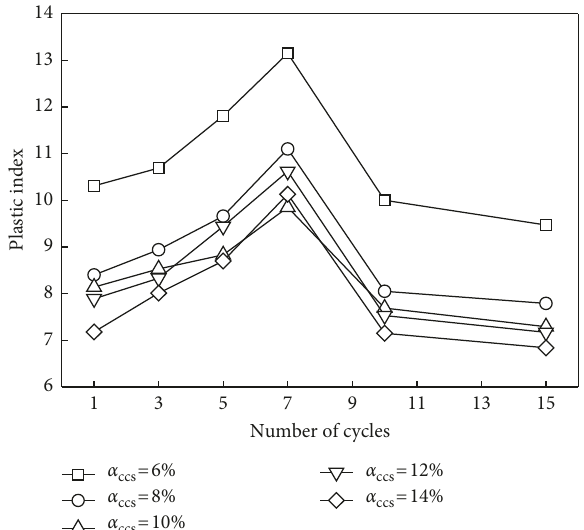
Figure 12: Evolutions of the plastic index with the number of drying-wetting